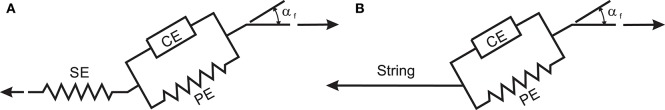
(A) Hill muscle model as shown in Thelen et al. (2003), (B) Adopted Hill-type muscle model for simulations.